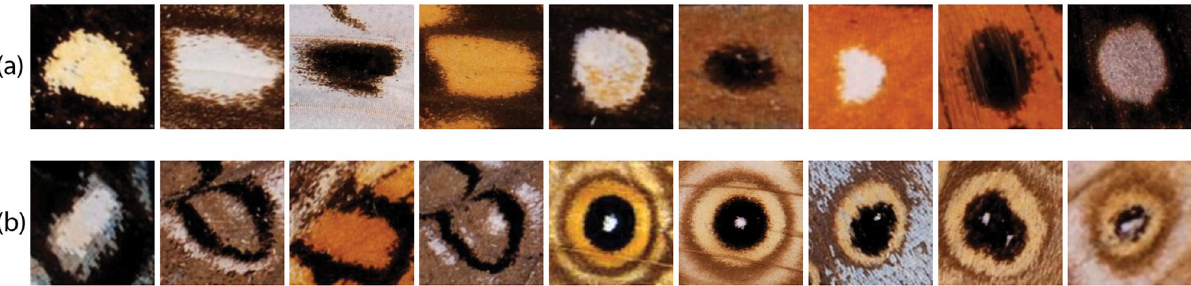
Fig 1. Examples of the types of pattern element present in dataset 1. Spots are pattern elements that develop a single spot of color. Eyespots are pattern elements that develop spots and rings of color. These include discal and marginal eyespots. The first are eyespots that develop around a cross- vein and are found in the center of the wing, and the second develop closer to the margin of the wing. ( a ) Spots. ( b )